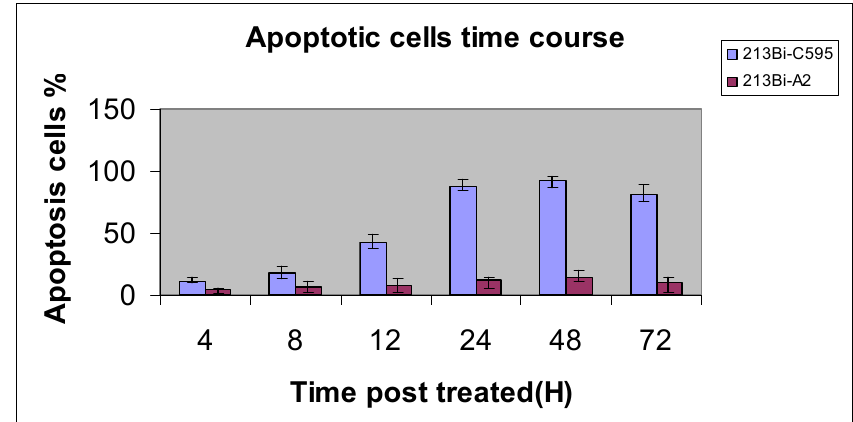
Figure 5. Time course for apoptosis for C595-AC compared with control [16].